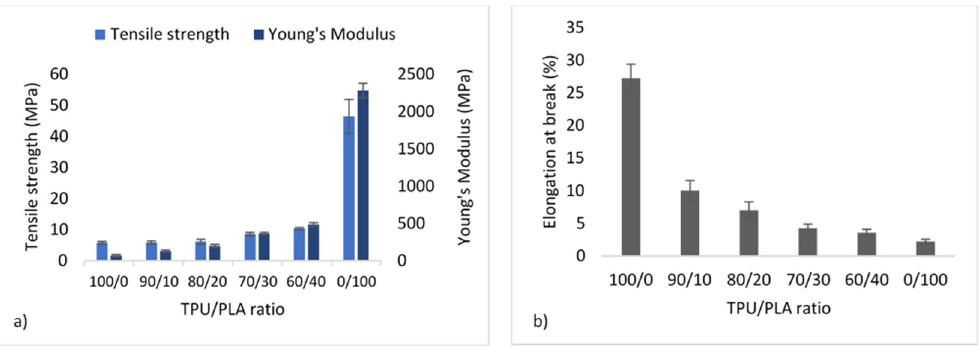
Figure 4. Mechanical properties of TPU/PLA blends showing ( a ) tensile strength and Young’s modulus in MPA, and ( b ) percentage of elongation at break.